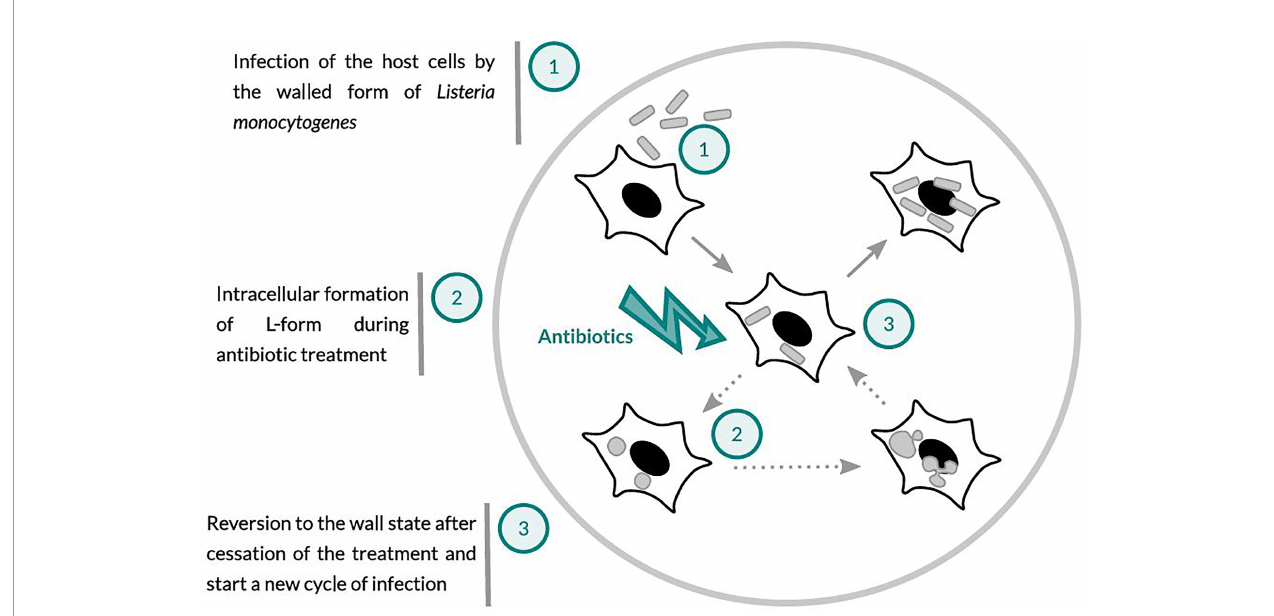
FIGURE 1 | Schematic presentation of the working hypothesis: (1) Host cells infected with Listeria monocytogenes . (2) Ampicillin treatment may lead to the conversion of intracellular Listeria monocytogenes to wall-de fi cient L-forms, which are intrinsically drug-resistant and able to survive and persist within the host cells. (3) After the cessation of antibiotic treatment, L-forms may revert back to the walled and fully virulent intracellular pathogen, which can trigger a relapse or recurrent infection.